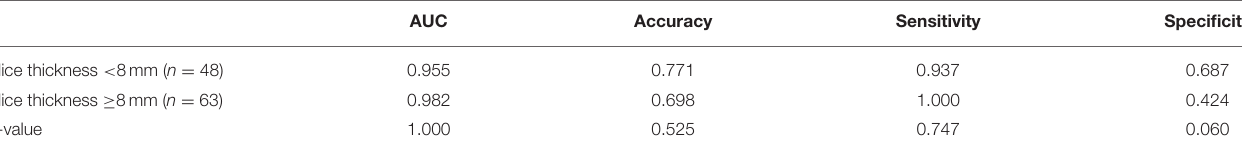
TABLE 5 | Performance comparison in the detection of AD on different slice thickness scans in the external testing